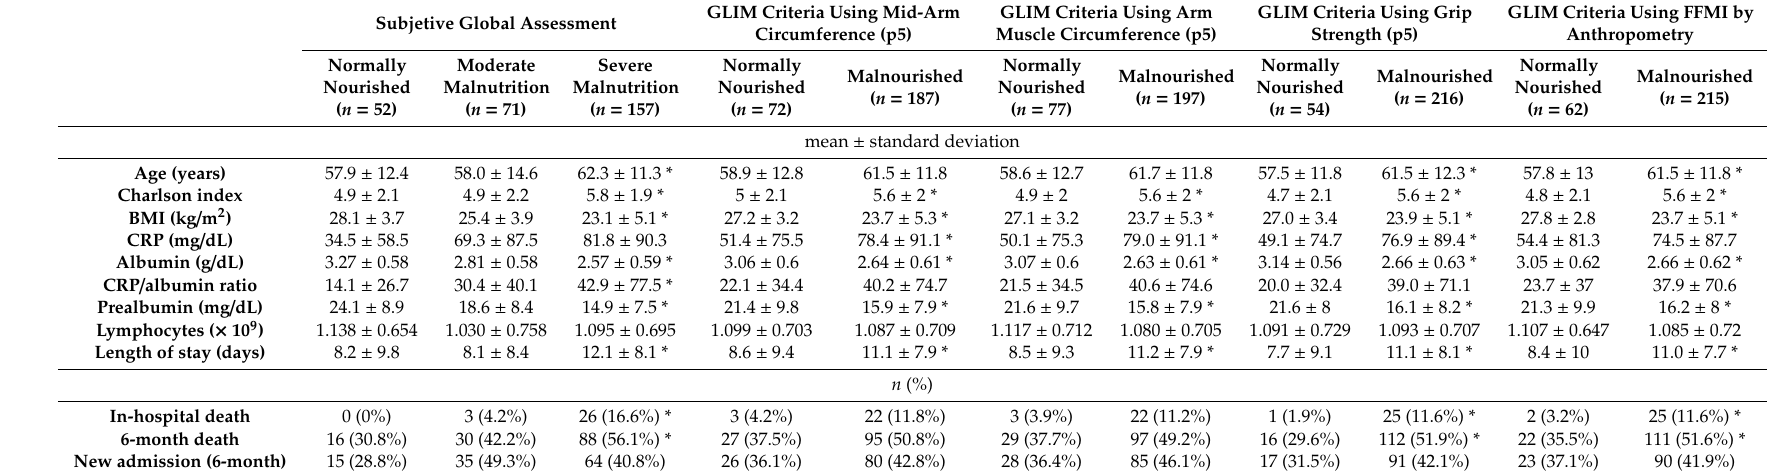
Table 3. Characteristics of patients admitted at medical oncology inpatient service, according to subjective global assessment and GLIM malnutrition criteria, according to di ff erent fat-free mass